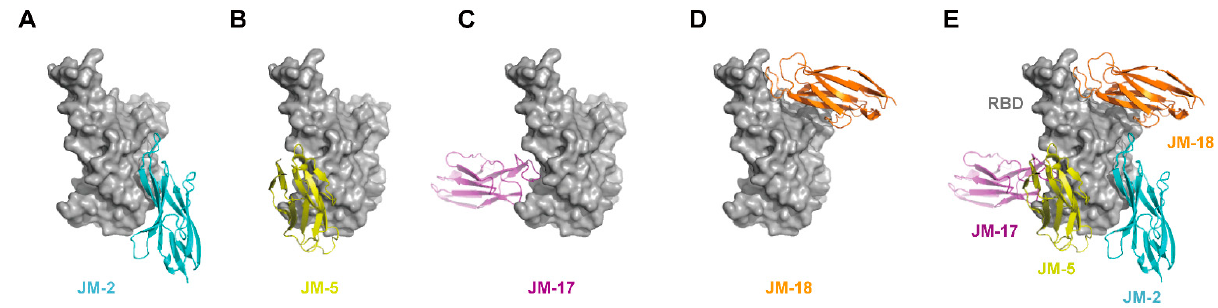
Figure 7. In silico molecular docking of VNARs binding to RBD. ( A – D ) Binding mode of JM-2 ( A ), JM-5 ( B ), JM-17 ( C ), and JM-18 ( D ) to RBD. ( E ) The docking structures alignment of JM-2 (cyan), JM-5 (yellow), JM-17 (magenta), and JM-18 (orange) in complex with RBD (gray).